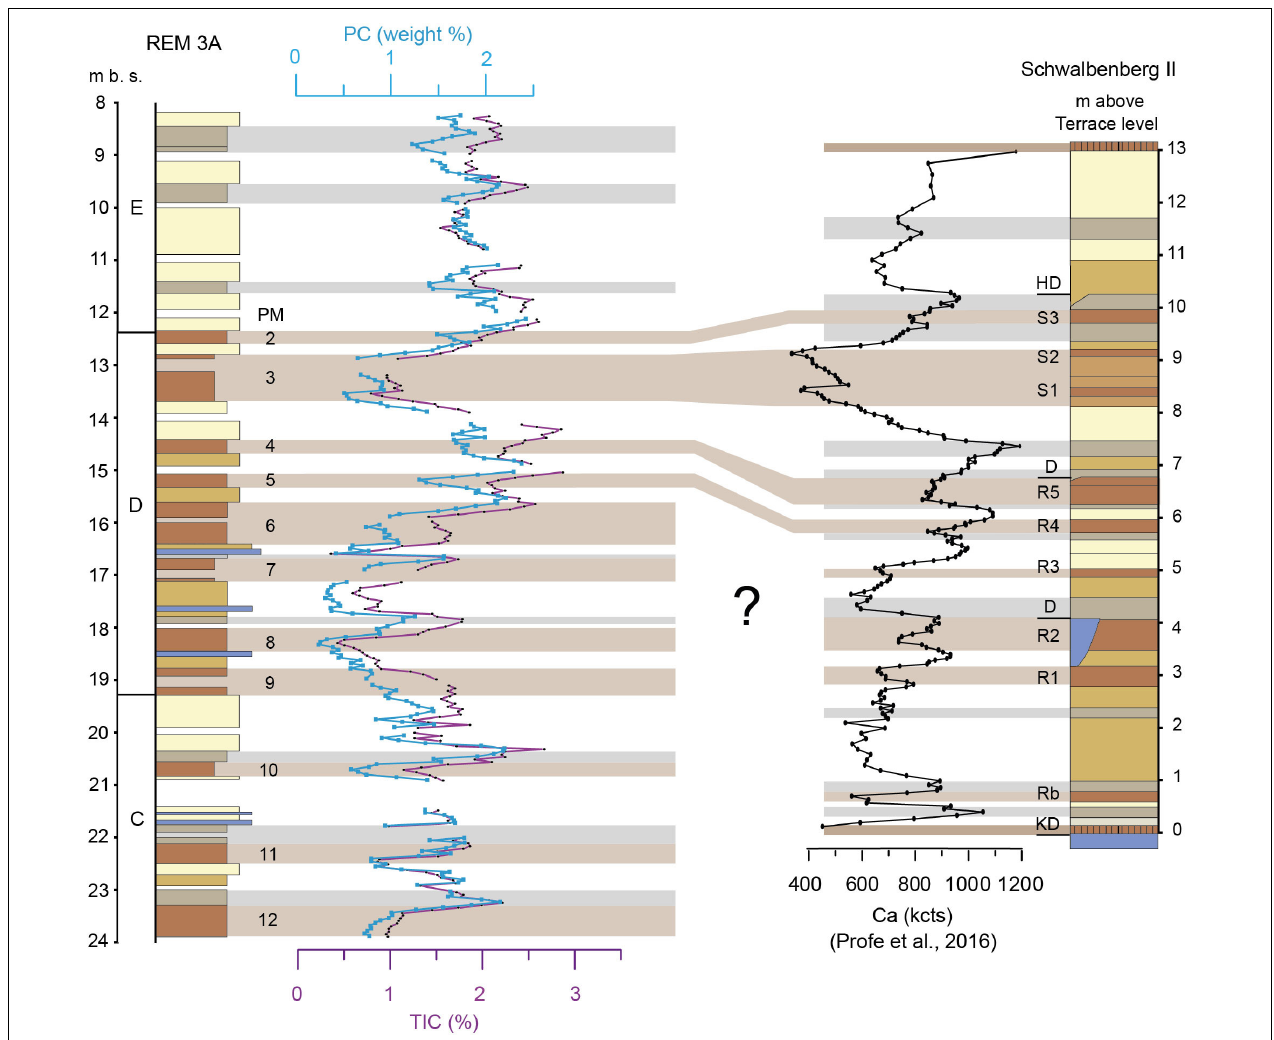
FIGURE 7 | Comparison of the TIC and Ca records and stratigraphy of the REM 3A and Schwalbenberg II section (re-drawn from Schirmer, 2012). Correlation for the uppermost parts of unit D and the Ahrgau Formation (starting above R1 up to the Hesbaye Discordance (HD)) reflecting late OIS 3 shows striking agreement amongst both LPS. However, R1 and R2 of the lower Remagen Soils and R3 of the upper Remagen Soils cannot be undoubtedly correlated to either PM (pedogenic member) 7,8,9. KD, Keldach Discordance; Rb, Reisberg Soil; D, Discordances; R1–R5, Remagen Soils; S1–S3, Sinzig Soils. Litho- and pedostratigraphic legend and pedogenic member (PM) according to Figure 3 . Gelic Gleysols are indicated by grey bars, Calcaric Cambisols by light brown bars and soil horizons associated with interglacial and early glacial conditions are represented by dark brown